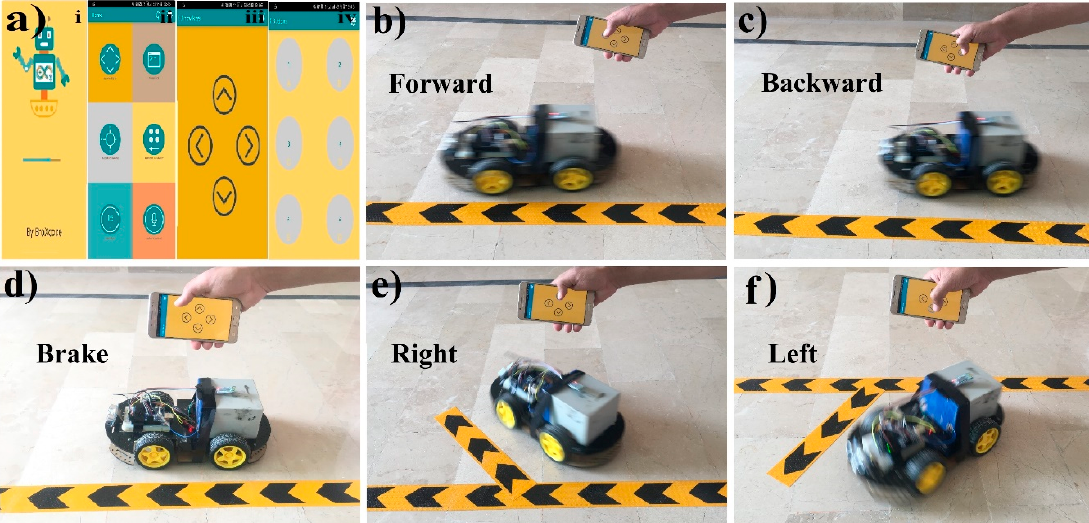
Figure 8. Result diagrams of the automatic robot car controlled with touch buttons of mobile-application. ( a ) i. Starting interface of the android application. ii. The homepage of an android application showing six different options of car control. iii. Touch arrow buttons interface for controlling car. iv. Simple touch buttons interface for controlling car. ( b ) The forward arrow button is touched, so the car is moving forward. ( c ) The backward arrow button is touched, so the car reverses. ( d ) The car is not moving (stopped) because none of the arrow buttons were touched. ( e ) The car is moving to the right direction as the right arrow button was touched. ( f ) The left arrow button was touched, so the car moves to the left direction. The complete demonstration video of the proposed system is available online [85].